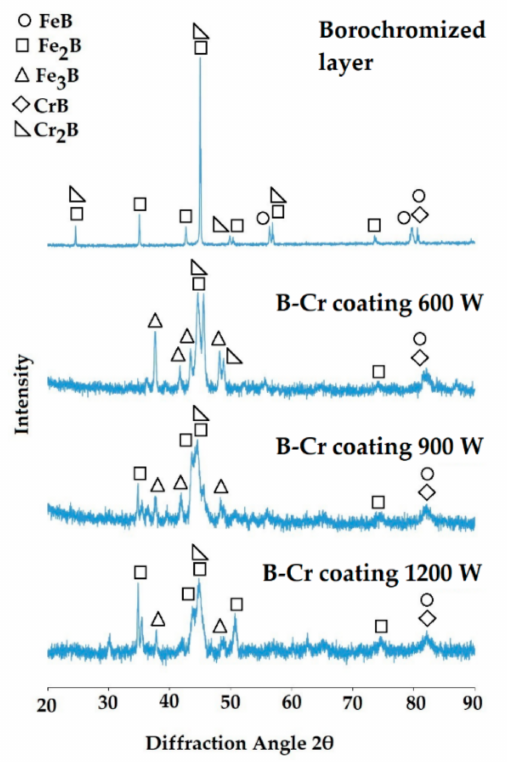
Figure 6. X-ray diffraction results of diffusion borochromized layer and B-Cr coatings after laser processing.